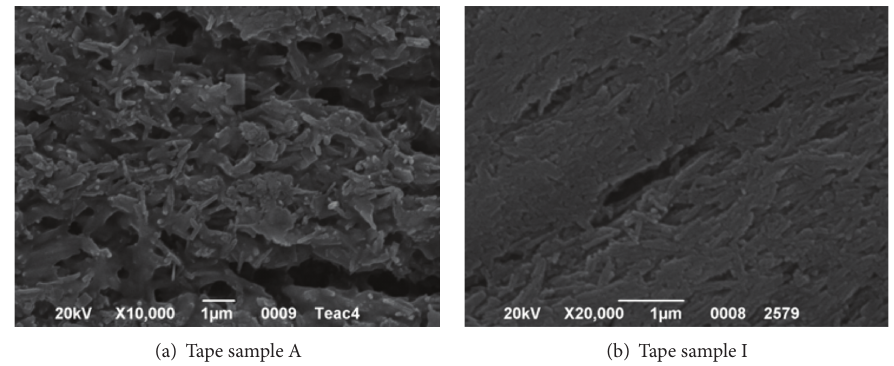
Figure 4: SEM analyses of sample A (a) and sample I (b) on the tape side that is coated with a ferromagnetic material. The first number from the bottom left of both figures is the power of the electrons beam (20kV); the second is the magnification rate ( × 10,000 in (a) and × 20,000 in (b)); the third is the scale (the white segment above indicates the proportion, here 1 𝜇 m); the progressive number in the analysis session; the sample identification